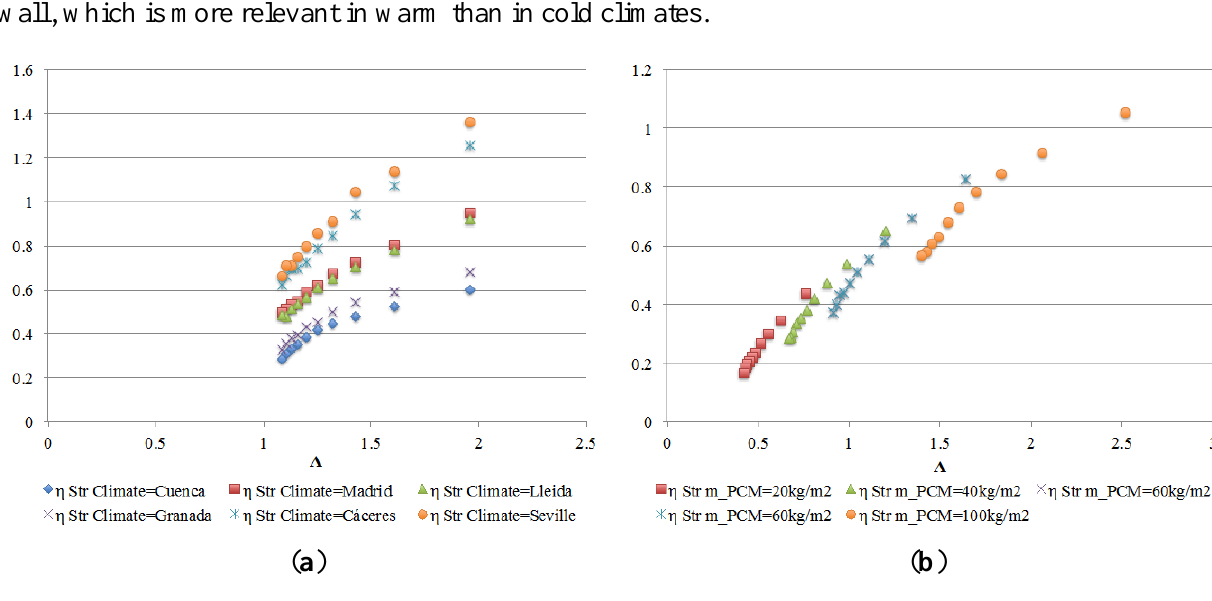
Figure 12. Efficiency as a regenerator: ( a ) different climates; ( b ) different amounts of